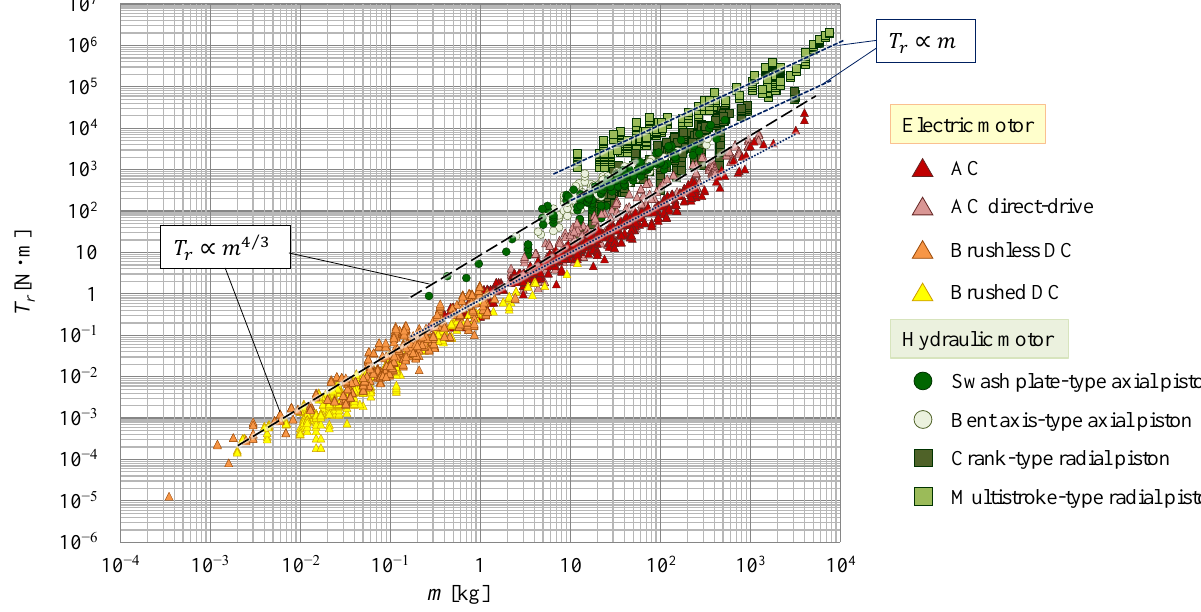
Figure 8. Correlation between weight and rated torque.